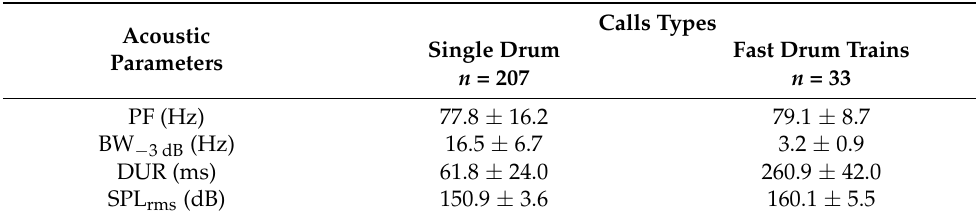
Table 2. Descriptive statistics (mean ± S.D.) of four acoustic parameters of calls produced by Chinese bahaba.